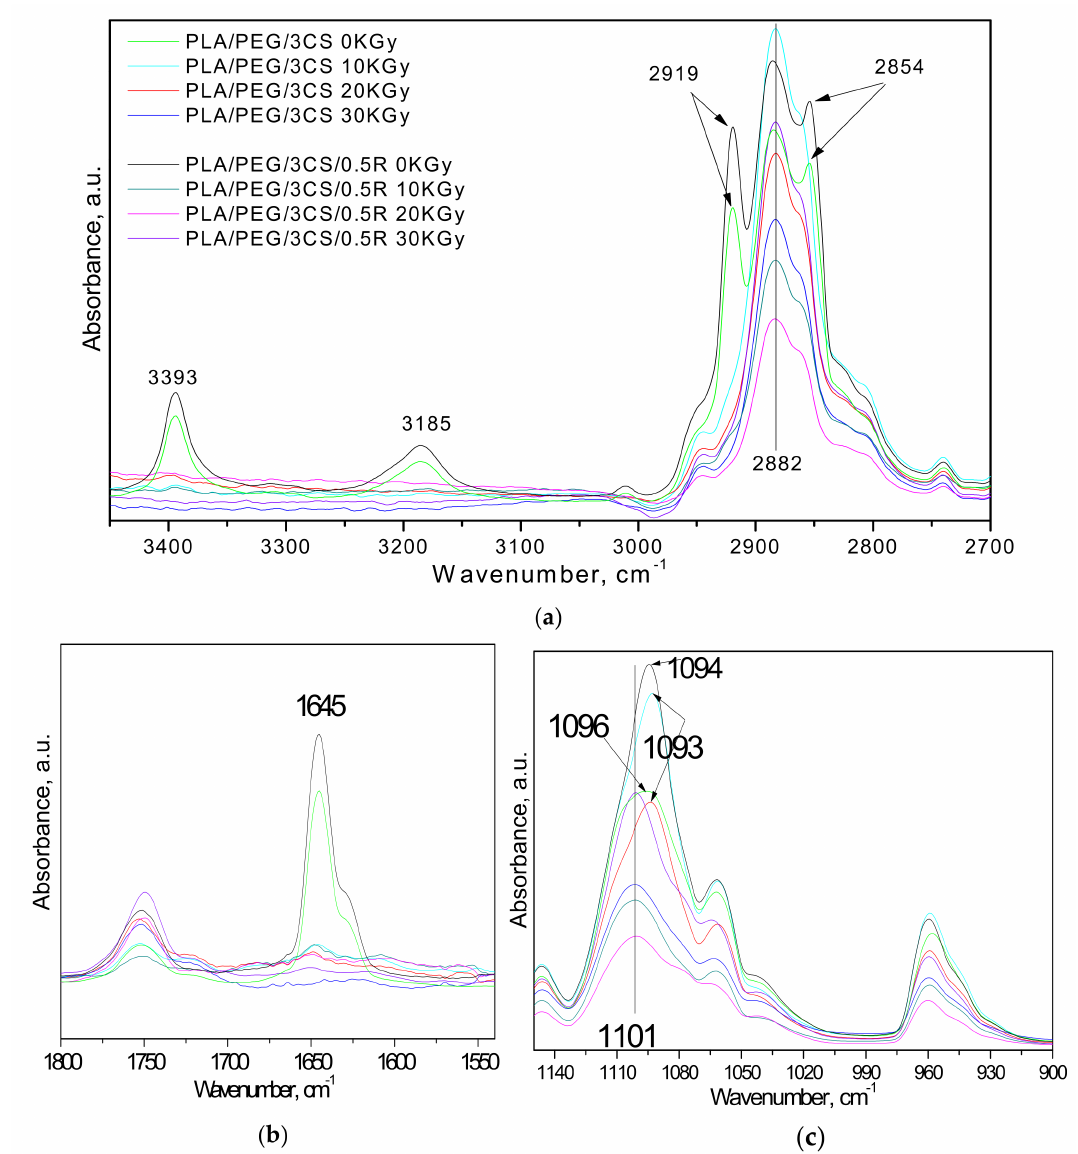
Figure 4. FT-IR spectra of the PLA/PEG/3 CS with/without rosemary extract powder (R), at 10, 20, and 30 kGy irradiation doses, respectively, in comparison with the non-irradiated ones in different spectral regions of: ( a ) 2700–3500 cm − 1 , ( b ) 1500–1800 cm − 1 , and ( c ) 900–1150 cm − 1